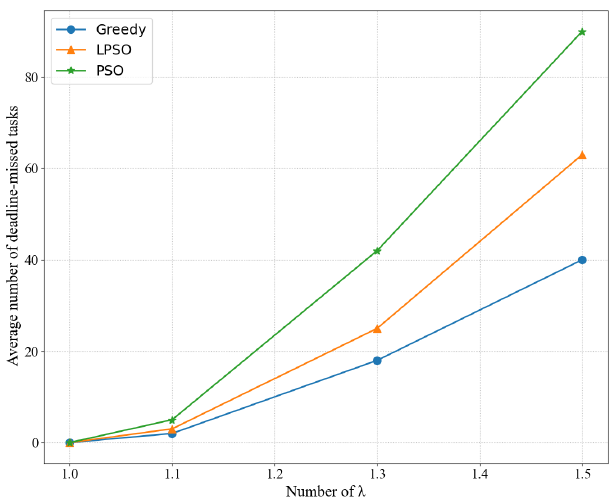
Figure 7. Completion degree of different algorithms under different arrival rates.